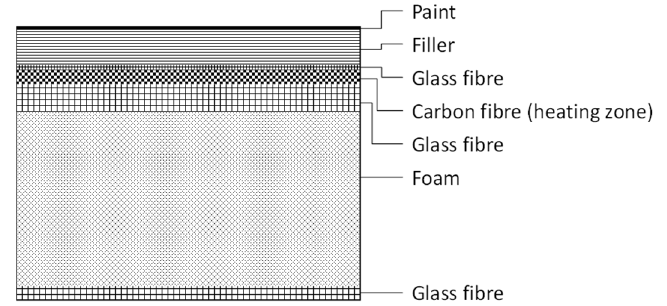
Figure 5. Schematic layout of the composite wing structure.